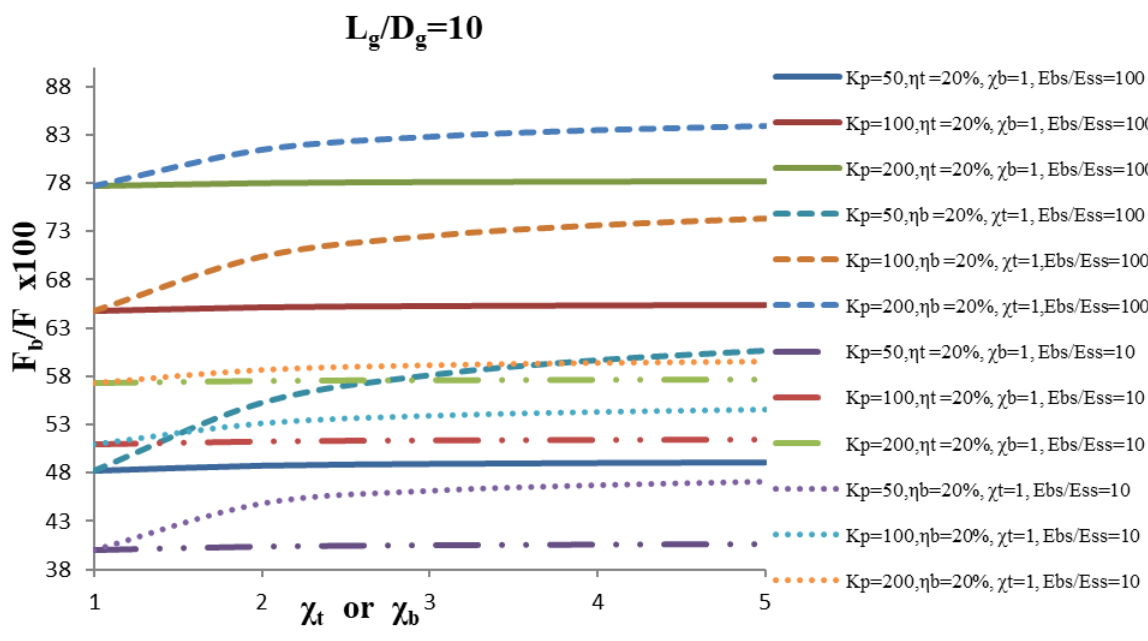
/F)x100 with strengthening factor for the top, χ b , and relative stiffness of bearing stratum, E p